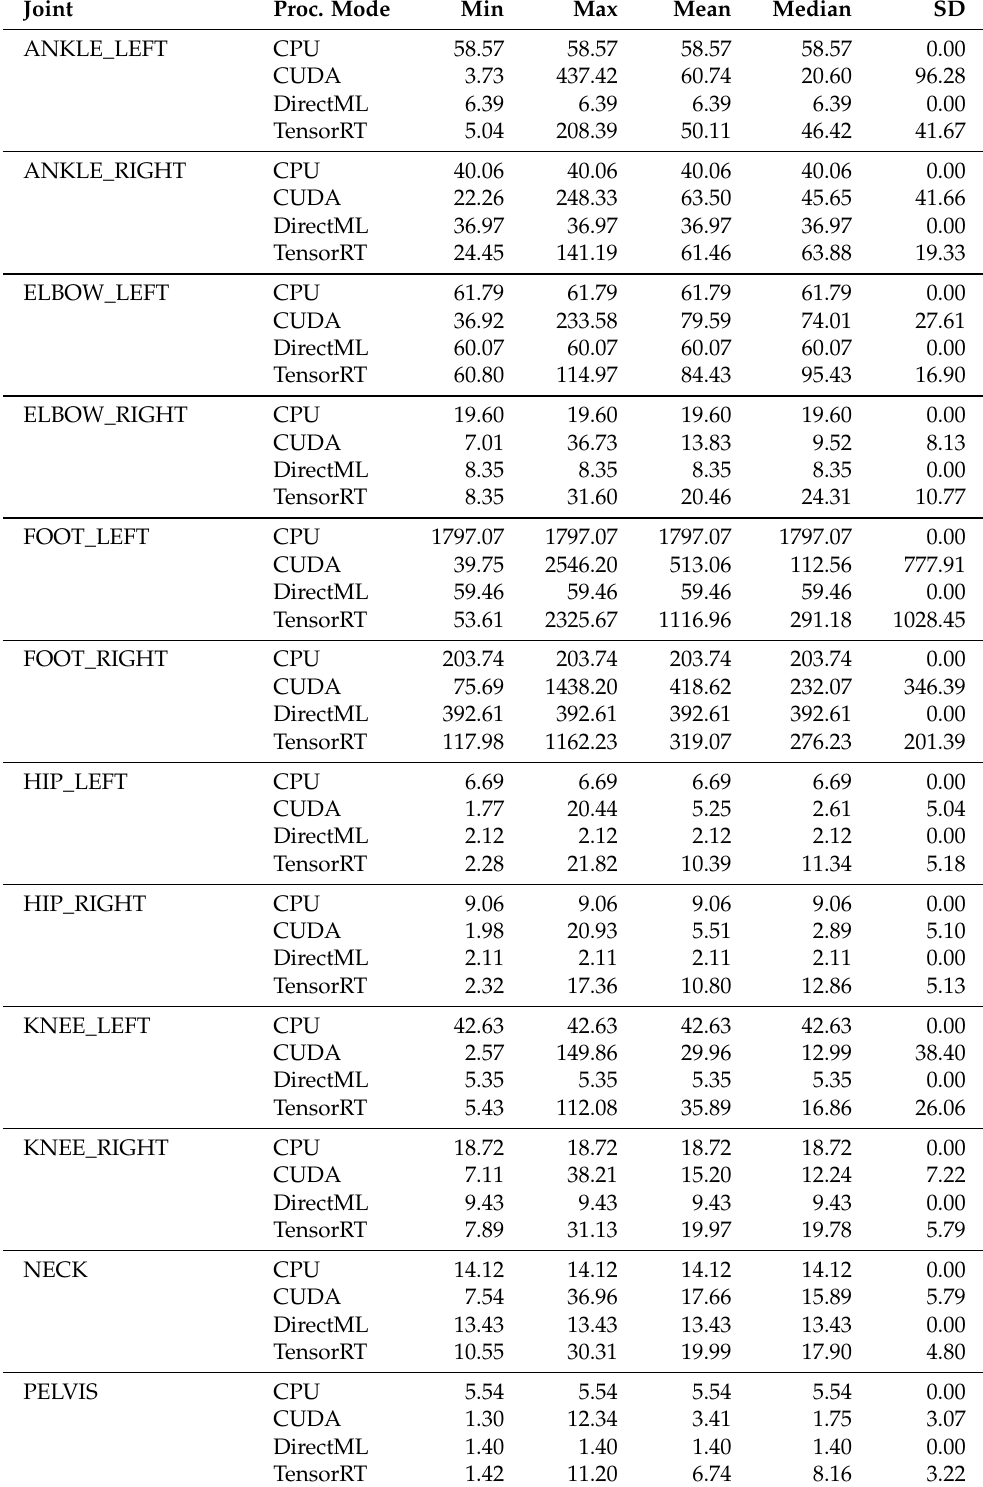
Table A2. Volume of the Ellipsoid containing 86.5% of all points for each combination of joint and processing mode. All values are in mm 3